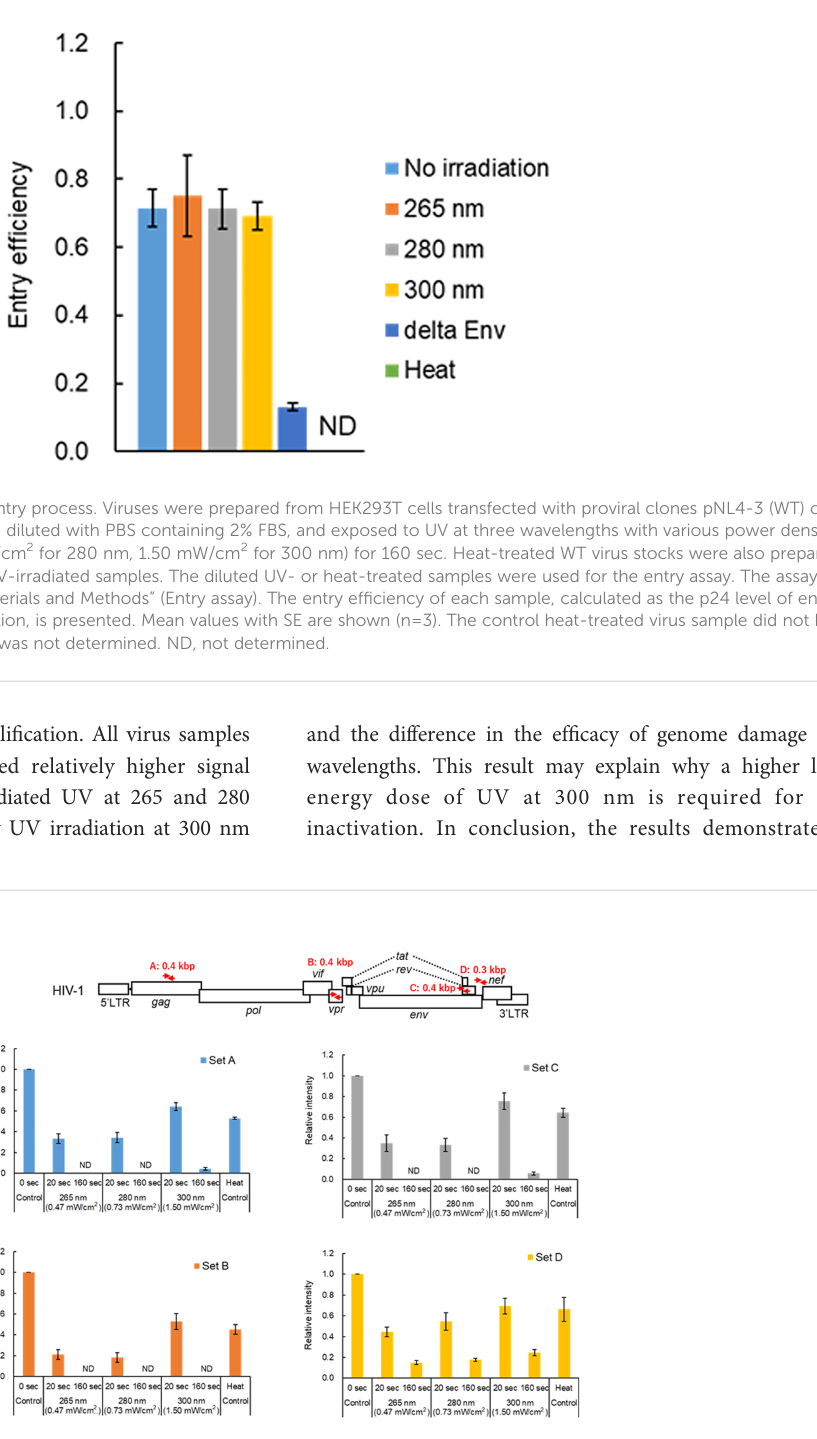
FIGURE 5 Effect of UV-irradiation on the HIV-1 genome. Virus stocks were prepared from HEK293T cells transfected with pNL4-3, and virus samples were appropriately prepared as indicated. The viral genome isolated was subjected to semiquantitative RT-PCR analysis using speci fi c primer sets. The primer sets used in the analysis and the sizes of the RT-PCR products are shown in red arrows and letters in the schematic HIV-1 genome at the top. For details of the primers, see “ Materials and Methods ” (Semiquantitative RT-PCR analysis). Signal intensities of the semiquantitative RT-PCR products were quantitated. The relative intensity is presented as a signal intensity of each sample relative to that of the sample without UV irradiation. Mean values with SE are shown (n=3). ND, not